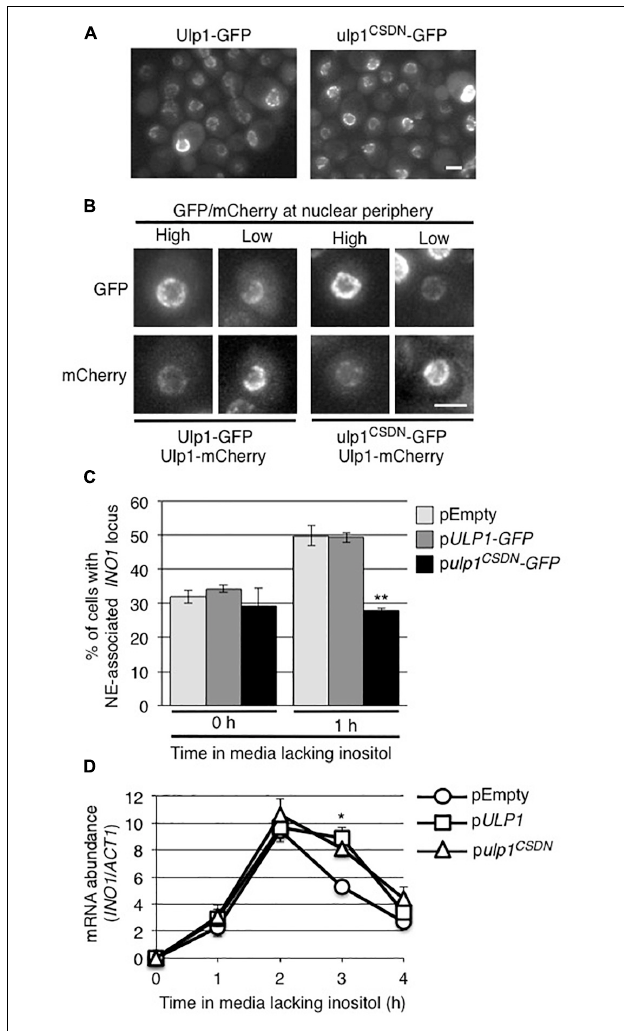
FIGURE 6 | The ulp1-CSDN mutant inhibits INO1 targeting to the NE. (A) Shown are images of WT cells producing exogenously expressed, plasmid-encoded Ulp1-GFP or Ulp1 CSDN -GFP. (B) The localization of plasmid-encoded Ulp1-GFP or Ulp1 CSDN -GFP in cells producing mCherry-tagged endogenous wild-type Ulp1 (Ulp1-mCherry) was examined. Shown are cells containing relatively high or low levels of the GFP fusion, likely stemming from cell to cell variability in plasmid copy number. Competition of NE-associated binding between the plasmid-encoded Ulp1-GFP or Ulp1 CSDN -GFP and endogenous Ulp1-mCherry proteins is indicated by the relative GFP and mCherry signal intensities at the NE. Scale bars = 2 µ m. (C) Recruitment of INO1 to the NPCs was measured as in Figure 2 in a WT strain containing INO1-lacO 256 /GFP-lacI and the indicated plasmid. Results are the means ± SD of three or more biological replicates. At least 50 cells were counted for each sample. (D) Levels of mRNA encoded by the INO1 gene were evaluated by qRT-PCR as described in Figure 2 following induction for the specified times in the indicated strains. Asterisks indicate a significant difference from WT (pEMPTY) as indicated by a Student’s unpaired t -test, * p < 0.05, ** p <